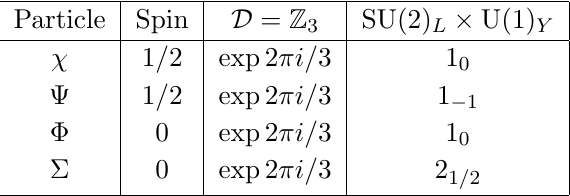
Table 1 . New particle content in our simpli(cid:12)ed